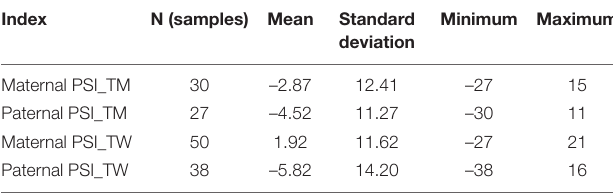
TABLE 2 | Means and standard deviations of parenting style